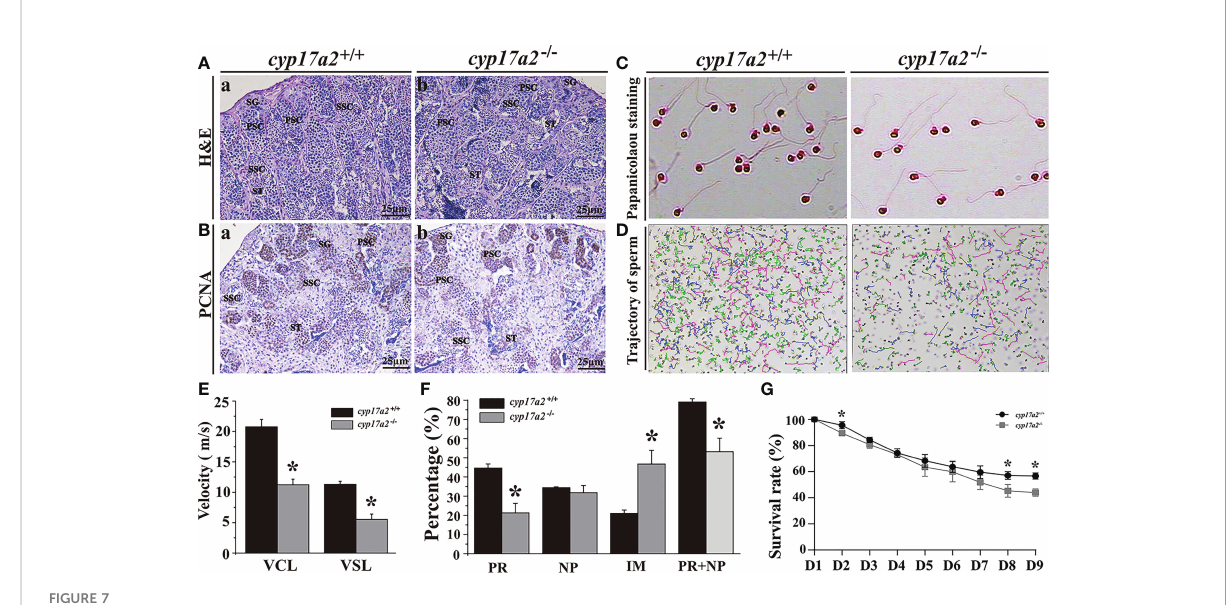
FIGURE 7 Mutation of cyp17a2 gene reduced sperm quality. (A) , H&E staining of testis from cyp17a2 +/+ (a) and cyp17a2 -/- (b) XY fi sh at 180 dah. (B) , Immunohistochemistry of PCNA in the testis of cyp17a2 +/+ (a) and cyp17a2 -/- (b) XY fi sh at 180 dah. SG, spermatogonia; PSC, primary spermatocytes; SSC, secondary spermatocytes; ST, spermatids. (C) , Morphology of sperm from cyp17a2 +/+ (a) and cyp17a2 -/- (b) XY fi sh. (D) , Trajectory of motile sperm from cyp17a2 +/+ (a) and cyp17a2 -/- XY (b) fi sh. (E) , Average speed of VCL (curve movement speed) and VSL (straight line movement speed) in cyp17a2 +/+ and cyp17a2 -/- XY fi sh. (F) , Quanti fi cation of different tracking parameters of PR (progressive sperm), PR+NP (non-progressive sperm) and IM (immotile sperm) in cyp17a2 +/+ and cyp17a2 -/- XY fi sh. (G) , Survival rates of embryos that cyp17a2 -/- and cyp17a2 +/+ XY fi sh arti fi cially inseminate with normal females (n=3). D, Days after fertilization. Data are expressed as the mean ± SD. Asterisk above the error bar indicate signi fi cant differences between groups tested by Student ’ s t -test (*,